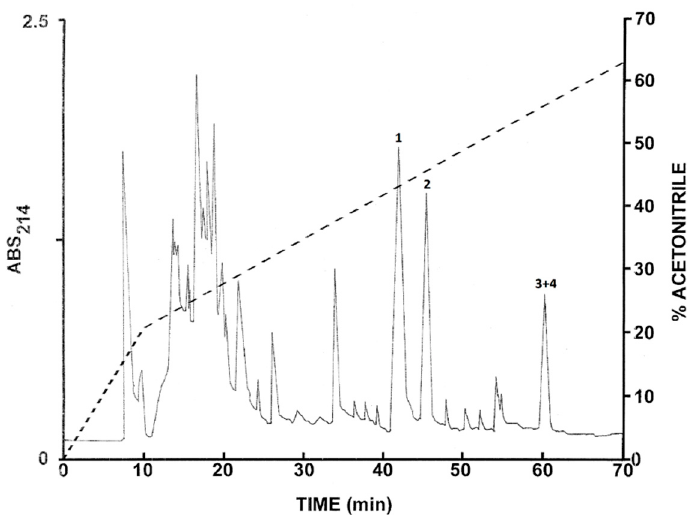
Figure 1. Elution profile on a semipreparative Vydac C ‐ 18 column of pooled skin secretions from nine Leptodactylus insularum frogs after prior concentration on Sep ‐ Pak cartridges. The dashed line shows the concentration of acetonitrile in the eluting solvent. Peaks 1–5 contain ocellatin ‐ related peptides that were purified to near homogeneity by further chromatography on Vydac C ‐ 8 and dimethylphenyl columns. Absorbance was monitored at 214 nm and fractions (1 min) were collected.